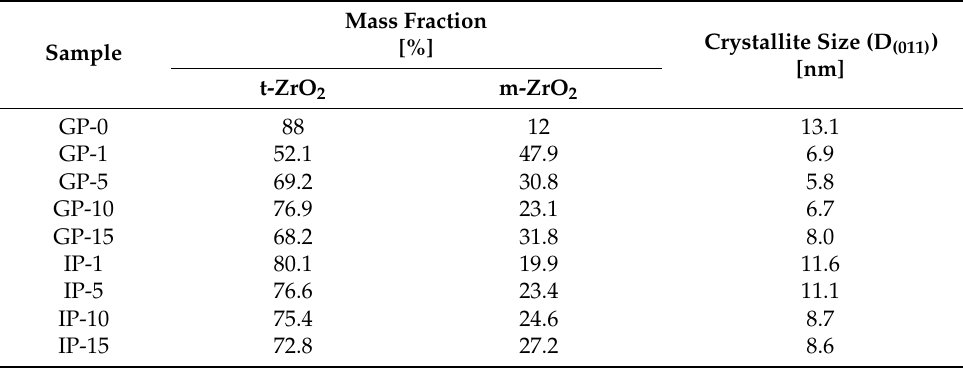
Table 2. Mass fractions of the tetragonal (t-ZrO 2 ) and monoclinic (m-ZrO 2 ) zirconia phases and the size of the tetragonal phase crystallites for two series of studied powders obtained via 2 h of calci- nation in air at 873 K.